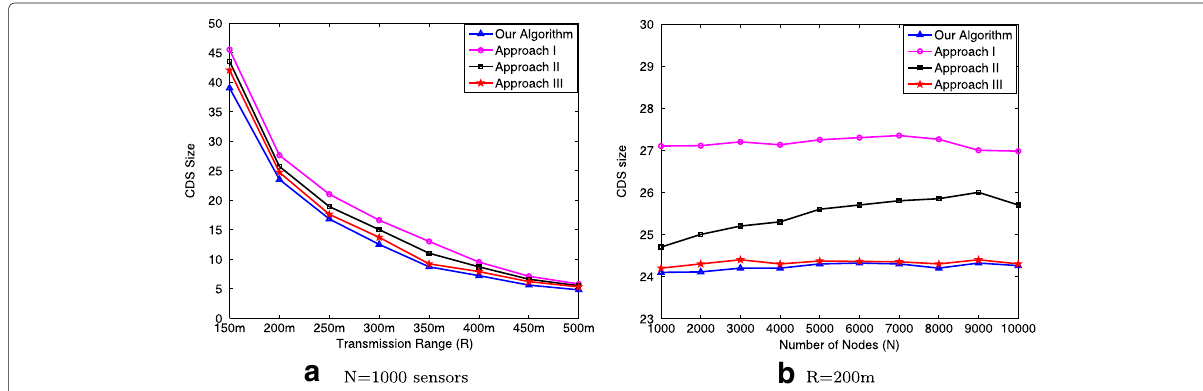
Fig. 7 Comparing results in the 1000 × 1000m 2 detection area. a The average performance of four algorithms when N is fixed to 1000 sensors and R changes from 150 to 500 m. b The average performance of four algorithms when R = 200 m and N varies between 1000 and 10,000